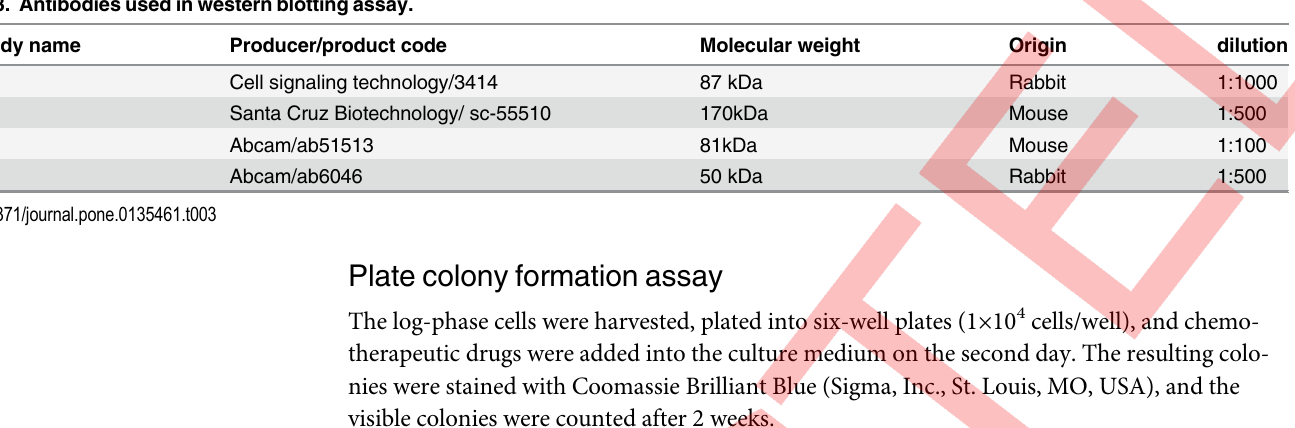
S2 Table. The consistently up-regulated and down-regulated lncRNAs between SGC7901/